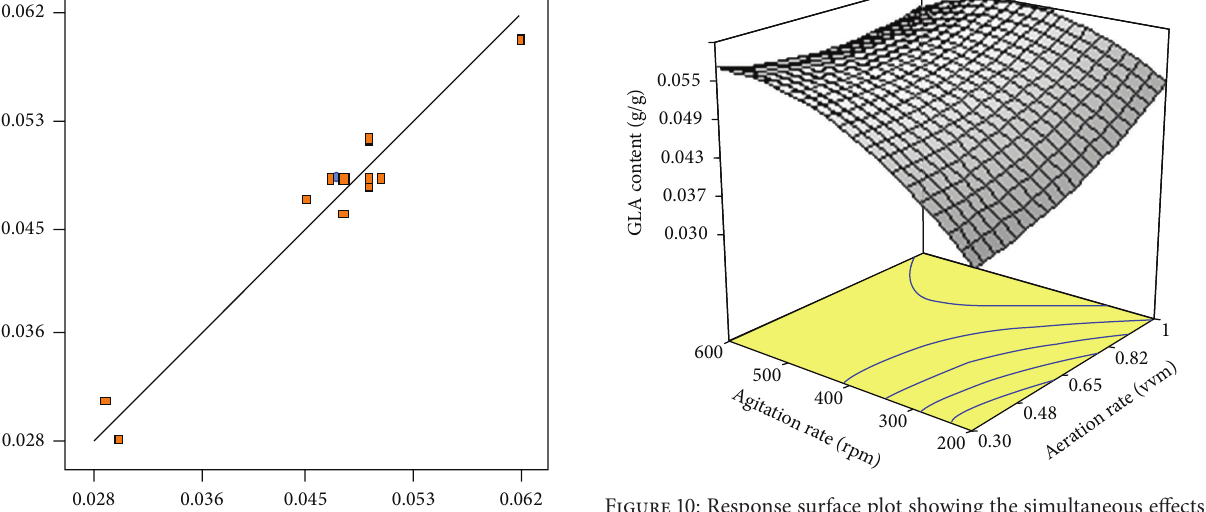
Figure 10: Response surface plot showing the simultaneous effects of aeration rate and agitation rate on GLA content produced by Cunninghamella bainieri 2A1.